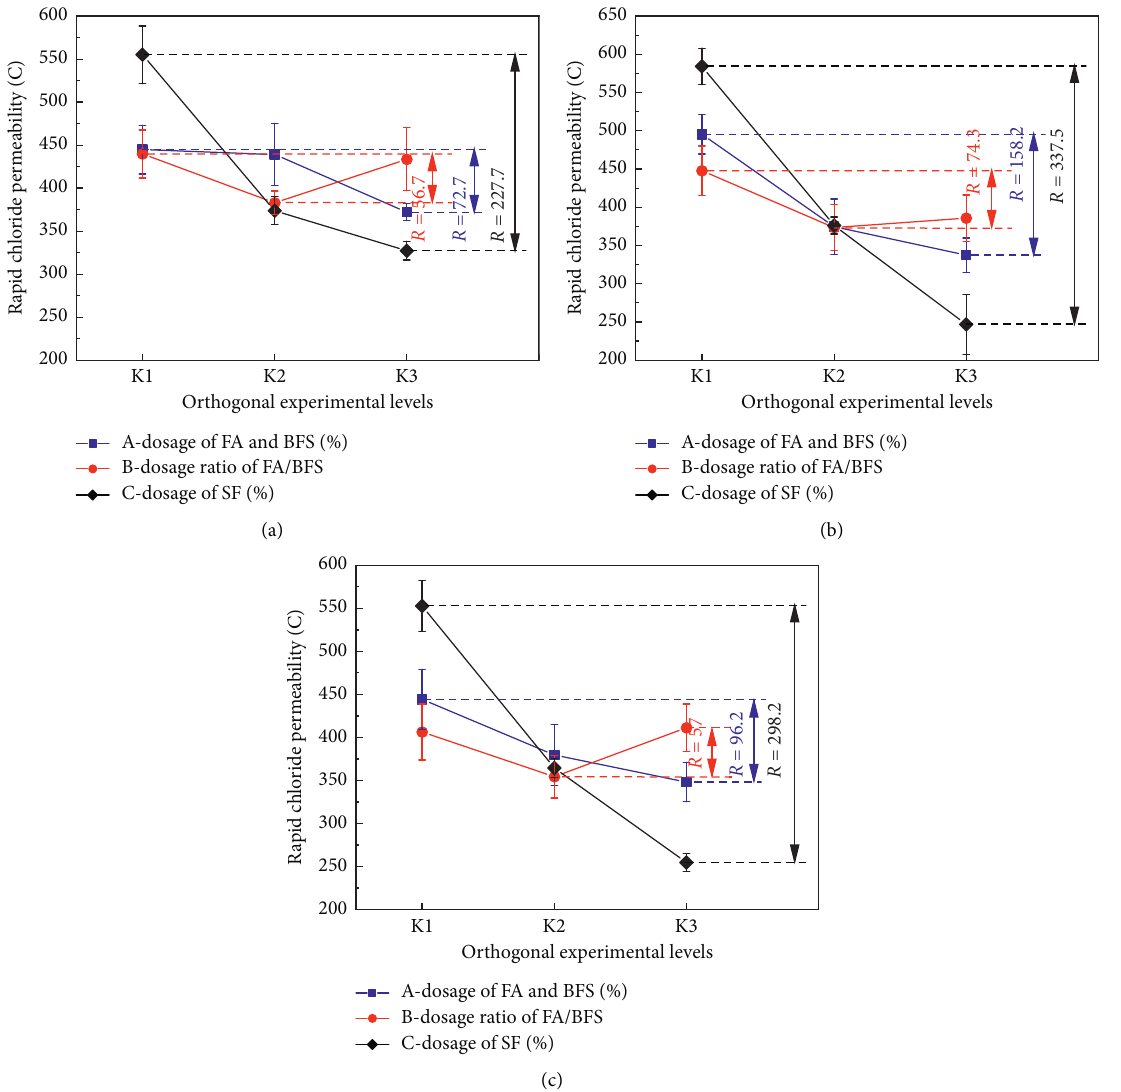
Figure 6: Range analysis between rapid chloride permeability and orthogonal experimental levels of cement concrete. (a) Air content of (2.5 ± 0.5)%. (b) Air content of (4.5 ± 0.5)%. (c) Air content of (6.5 ±